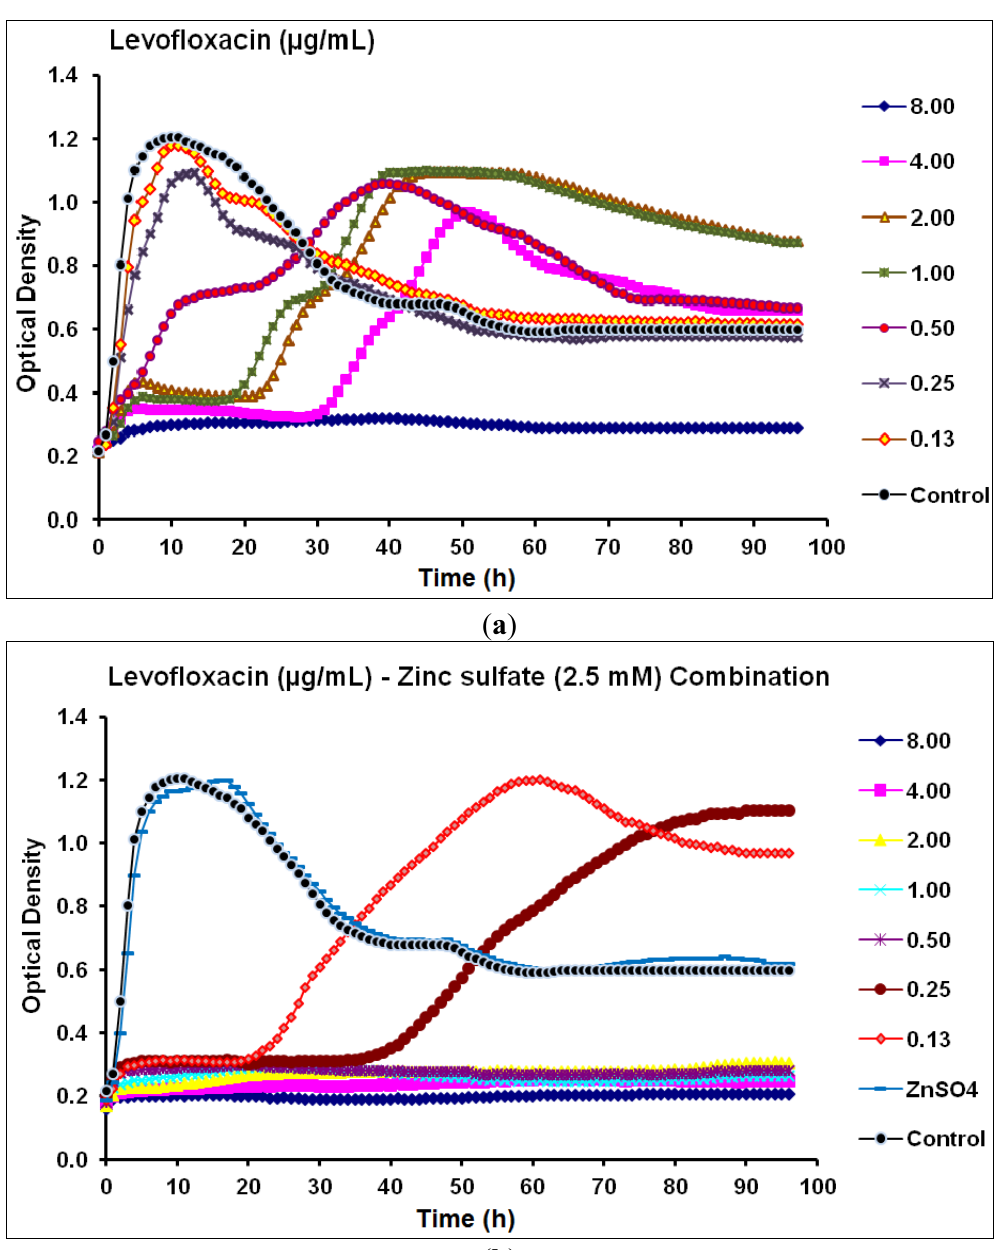
Figure 3. Real-time data showing the effect of ( a ) Levofloxacin alone (0.13–8.00